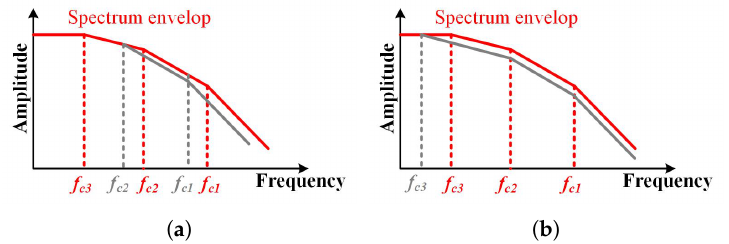
Figure 28. Influence of switching characteristics of SiC MOSFET on spectrum envelop of the drain- source voltage v ds , ( a ) variation of R g ( ex ) , ( b ) variation of f s